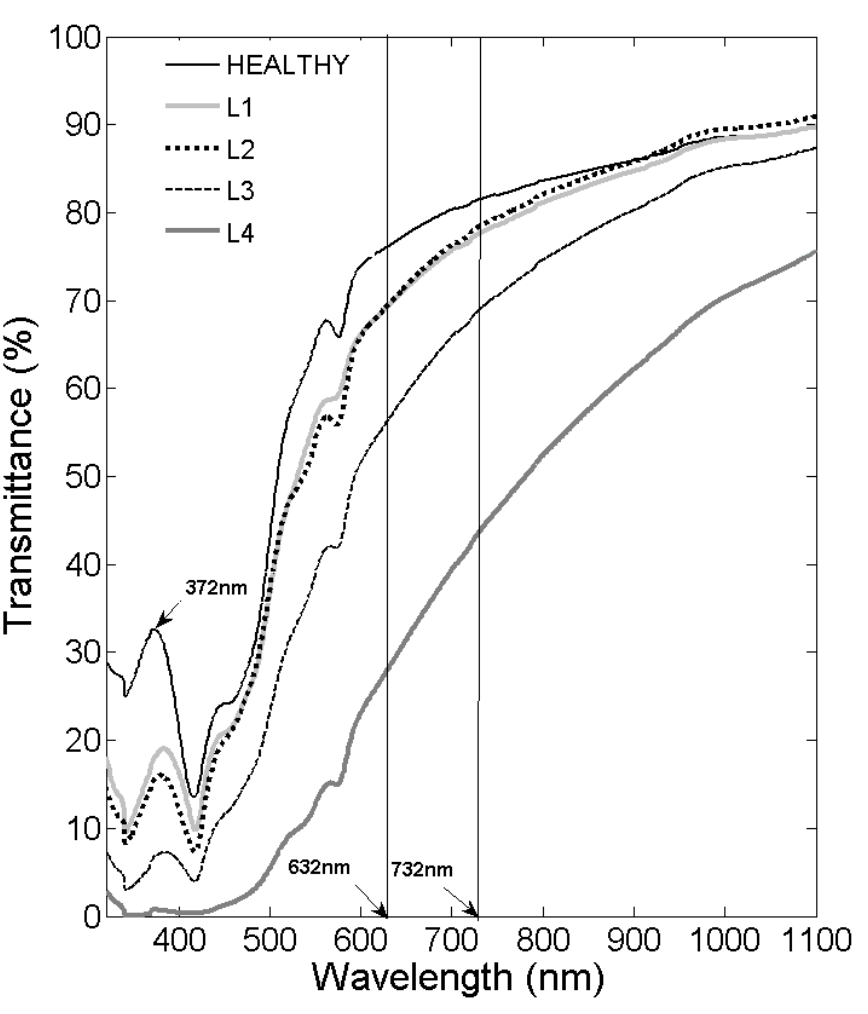
Figure 3. Transmittance spectra (average value) of healthy and lipemic blood samples classified from L1 to L4 at wavelengths between 320 nm and 1100 nm. The graph indicates the location of the two wavelengths that are used to calculate the slope between the transmittance values 632 nm and 735 nm.